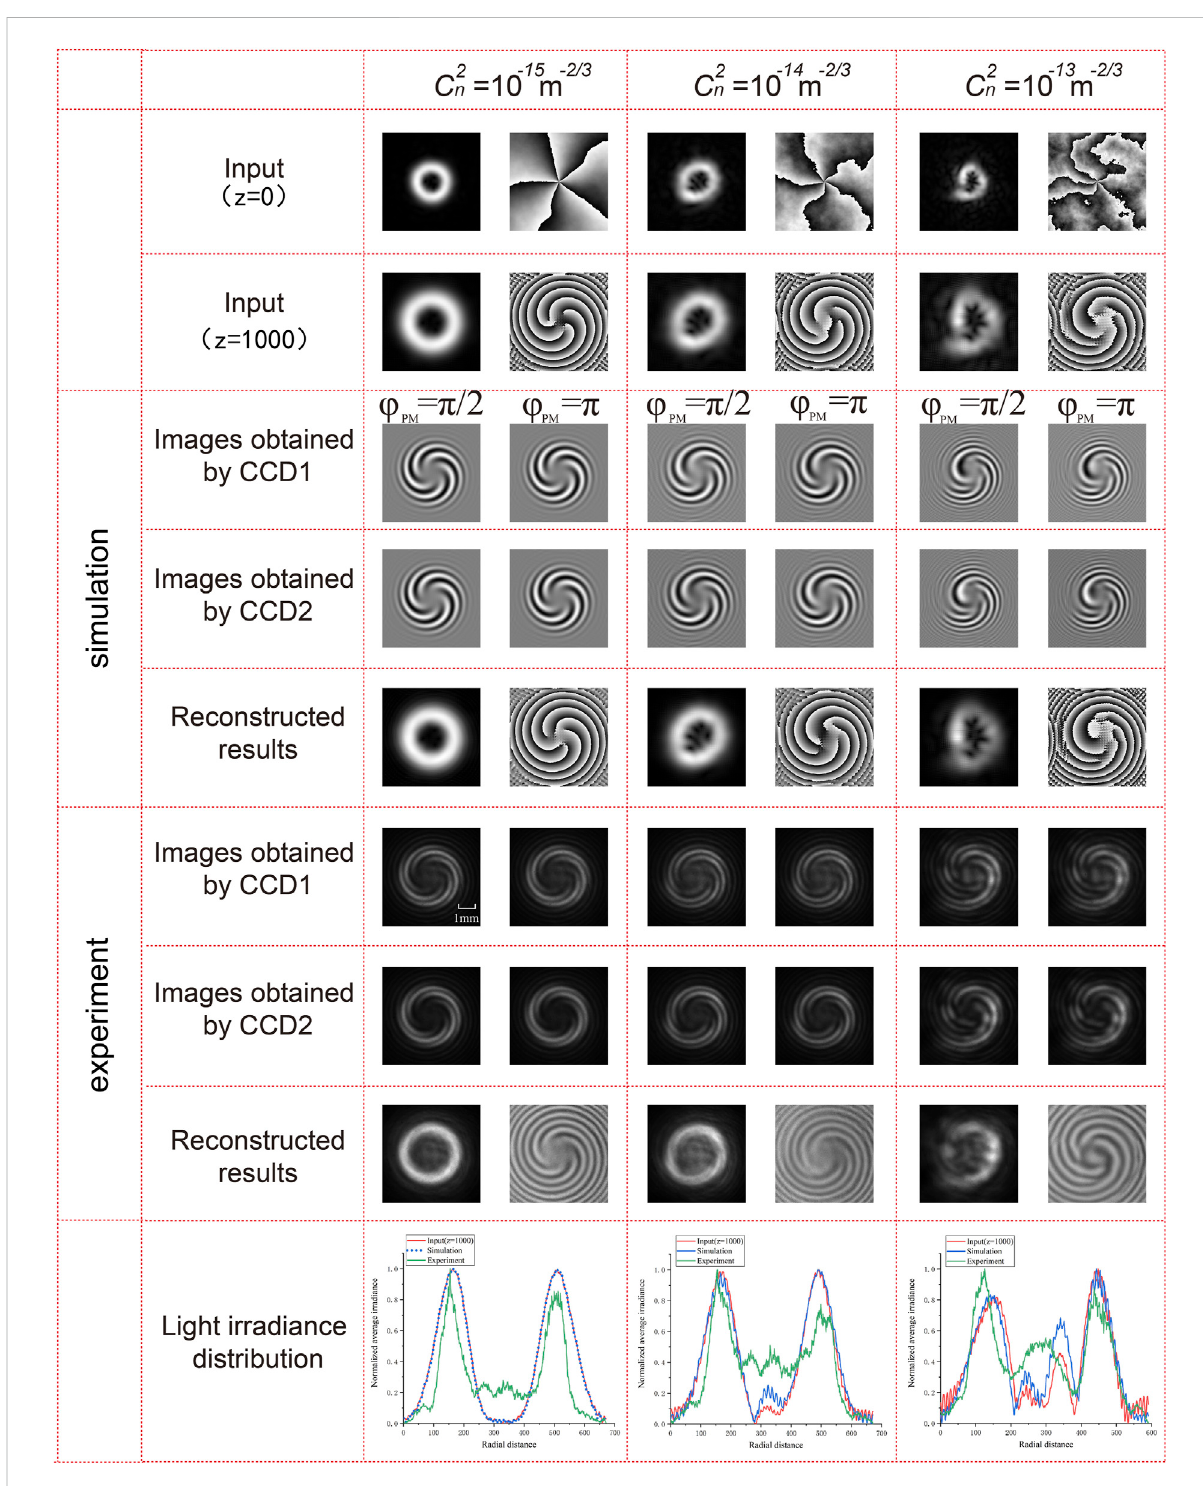
FIGURE 6 Simulation and experimental results of the proposed scheme to capture the amplitude and phase pro fi le of the OAM beam ( ℓ = 5) under the presence of atmospheric